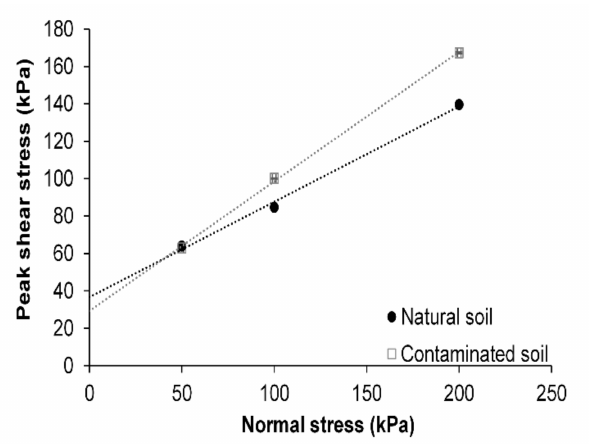
Figure 3. Effect of diesel contamination on the direct shear behavior of